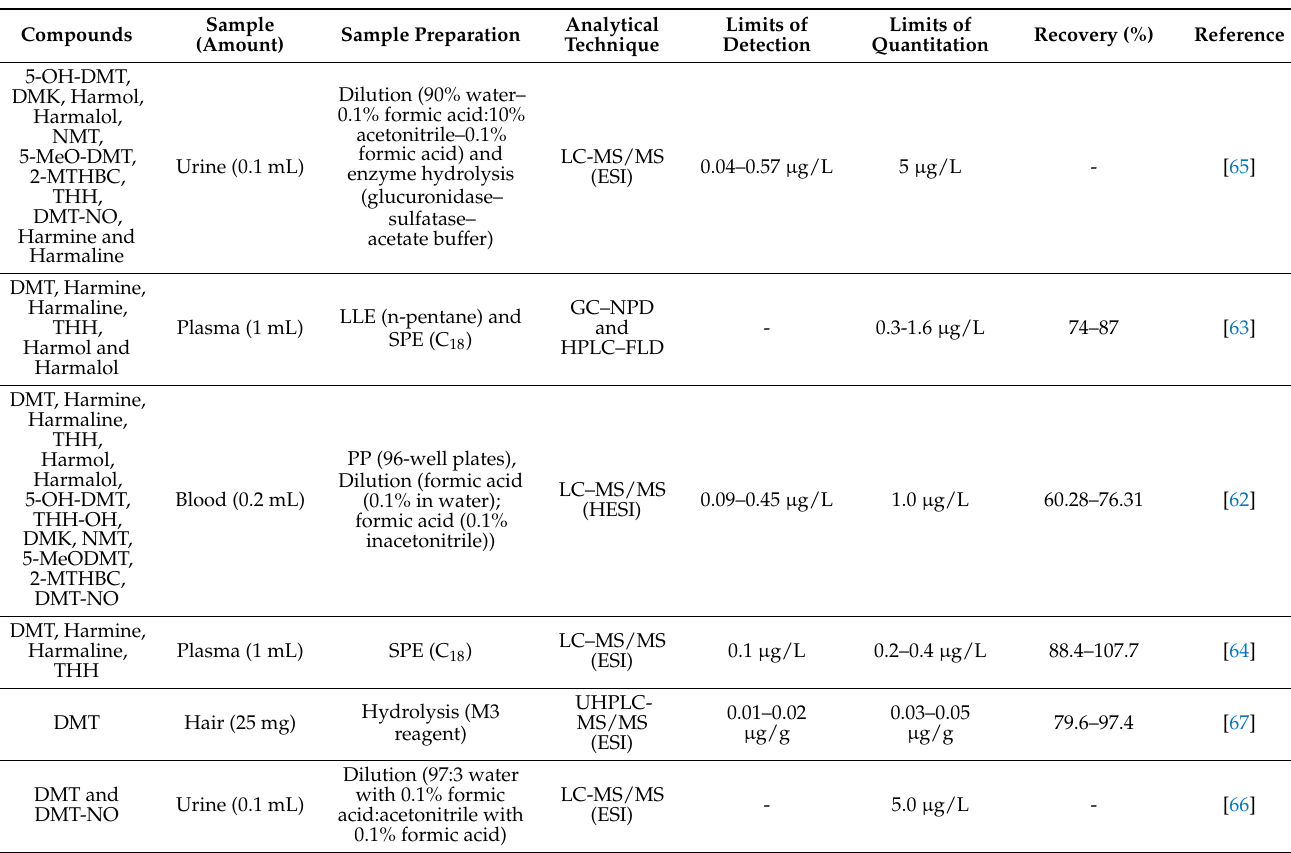
Table 2. Analytical methods for the determination of the main components of